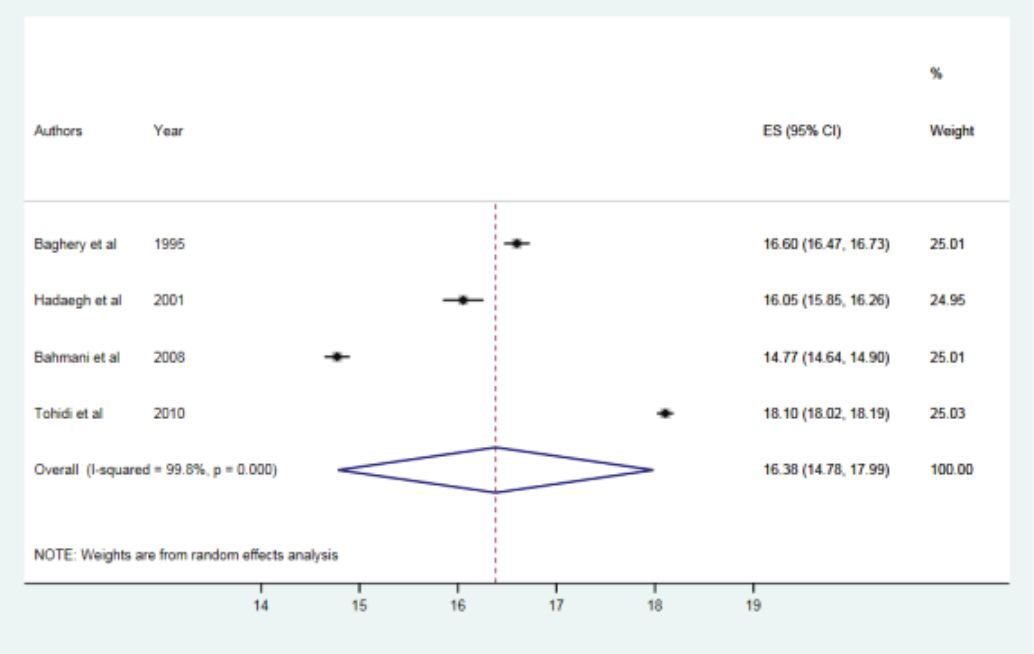
Figure 3. Mean eye protrusion in total